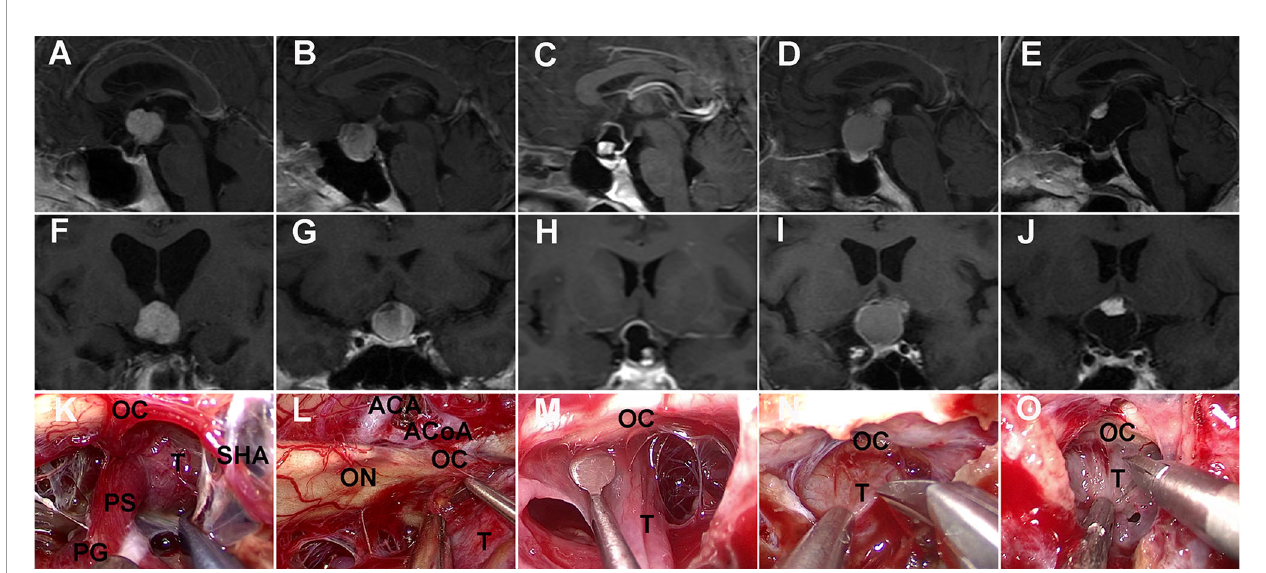
FIGURE 2 | Adhesion strength between craniopharyngioma and optic nerves was intraoperatively evaluated. (K, L, M) No or loose adhesion. Contrast-enhanced T1-weighted MRI scans (A, F) showing an intrinsic third ventricular solid tumor compressing forward the optic chiasm. Intraoperative view (K) revealing that the proximal part of the pituitary stalk extending from the gland could be identi fi ed as intact and at a normal size before tumor resection. Preoperative MRI scans (B, C, G, H) showing a sellar-suprasellar/suprasellar cystic-solid tumor stretching upward the optic chiasm. Surgical view (L, M) showing that the tumor can be easily separated from the optic nerves by dissector. (N, O) Tight adhesion. Preoperative MRI scans (D, E, I, J) showing sellar-suprasellar cystic-solid tumors displacing the optic chiasm. Intraoperative video-captured photographs (N, O) showing tight adhesion between the tumor and the optic apparatus needing sharp dissection using scissors. OC, optic chiasma; ON, optic nerve; T, tumor; PG, pituitary gland; PS, pituitary stalk; SHA, superior hypophysial artery; ACA, anterior cerebral artery; ACoA, anterior communicating